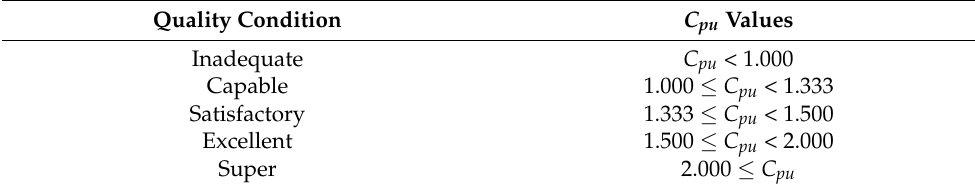
Table 1. The five quality